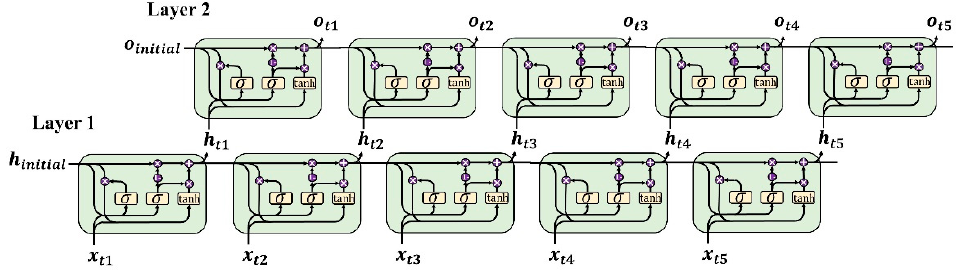
Figure 3. The typical structure of a double layer stacked GRU network, the second layer obtains the state of the first layer for further calculation.